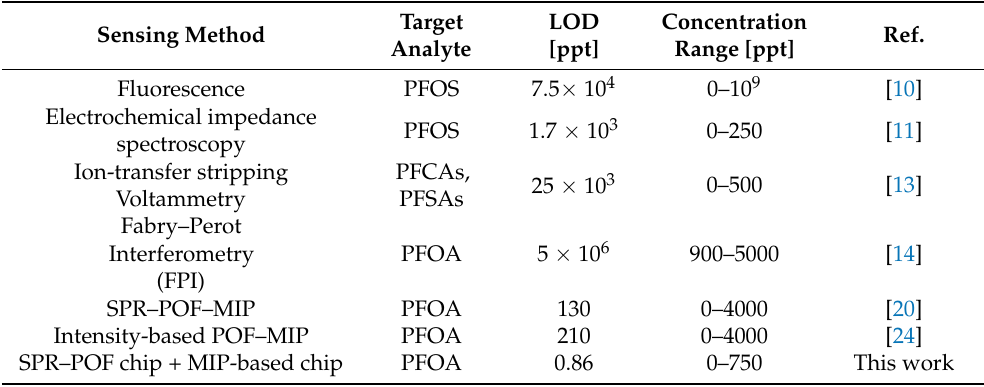
Table 6. PFAS detection exploiting different sensing methods: a comparative analysis in terms of LOD and concentration range of PFAS